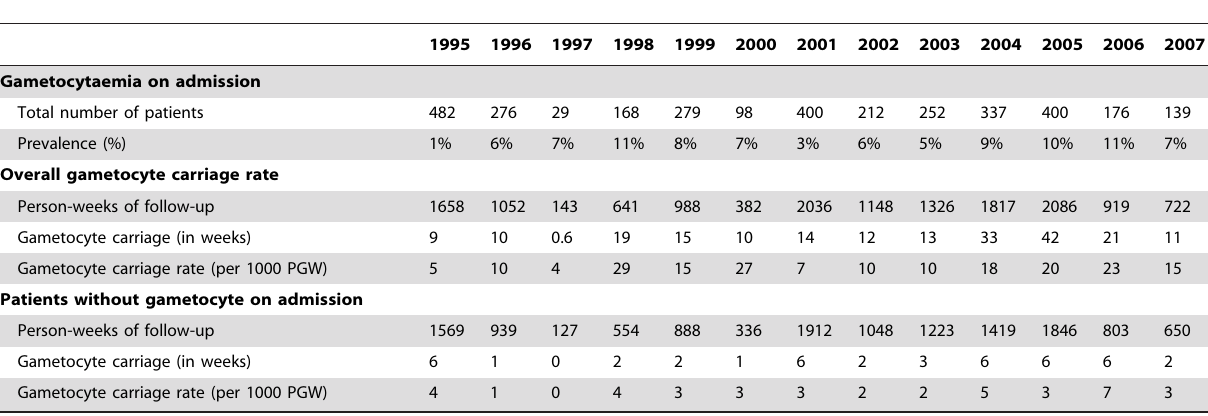
Table 4. Gametocyte prevalence rate on admission and gametocyte carriage rate (overall and among patients without gametocytaemia on admission).